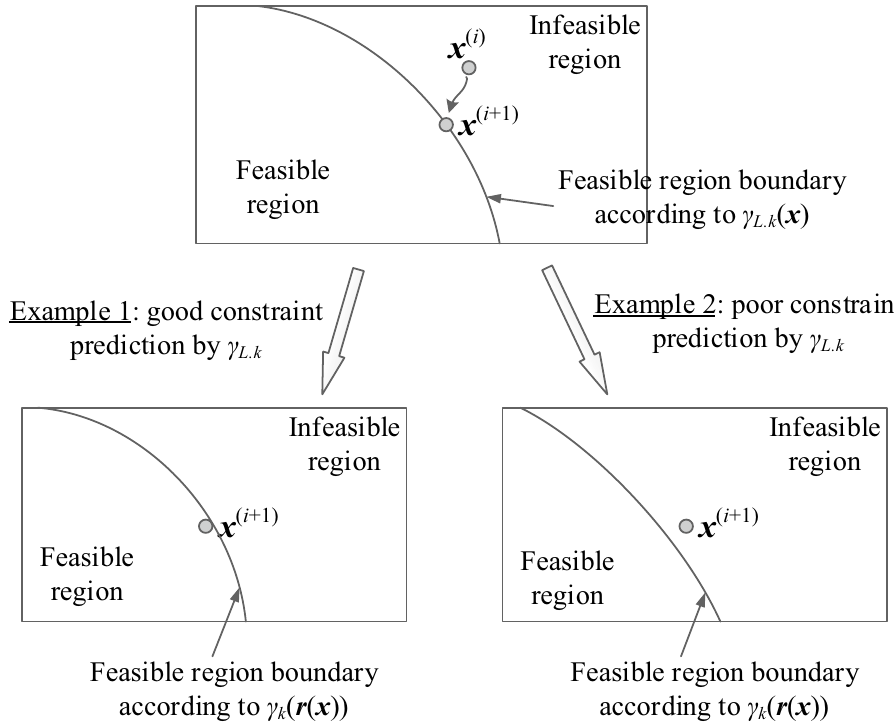
Figure 1. Prediction of design constraints by means of linear approximation model γ L.k of (Eq. 10). The top picture illustrates relocation of the design from x ( i ) to x ( i +1) obtained by solving (Eq. 8). In this example, x ( i ) is assumed feasible, whereas x ( i +1) is allocated at the boundary of the feasible region according to the approximation model γ L.k . The bottom-left picture illustrates a case of satisfactory constraint prediction by γ L.k , i.e., the design x ( i +1) is feasible according to the EM simulation data. The bottom-right picture shows a case of poor prediction: the design x ( i +1) is infeasible according to the true constraint value evaluated through EM analysis. The latter will result in a reduction of the search region size δ ( i ) in the next iteration (cf. Eqs. (13,